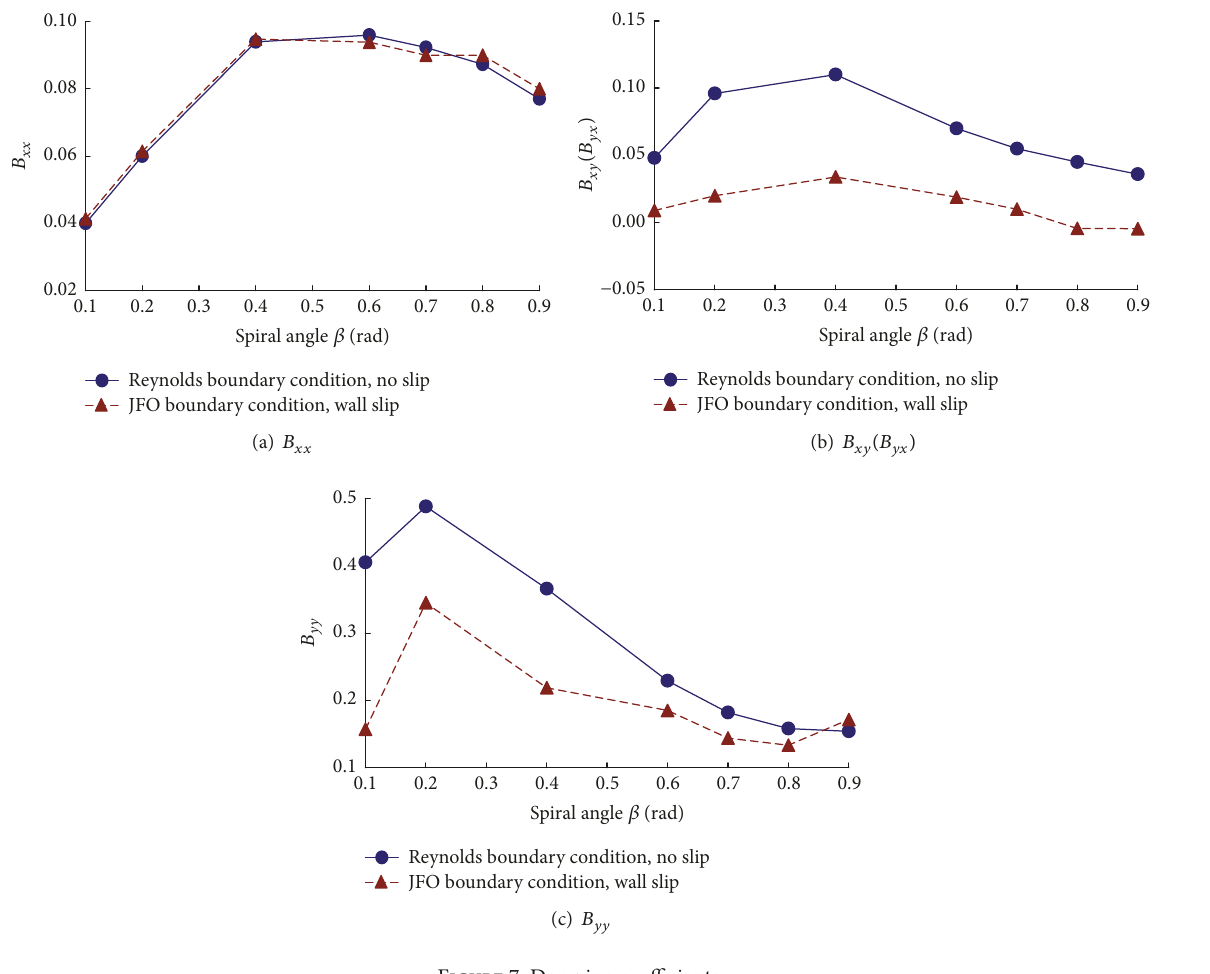
Figure 7: Damping